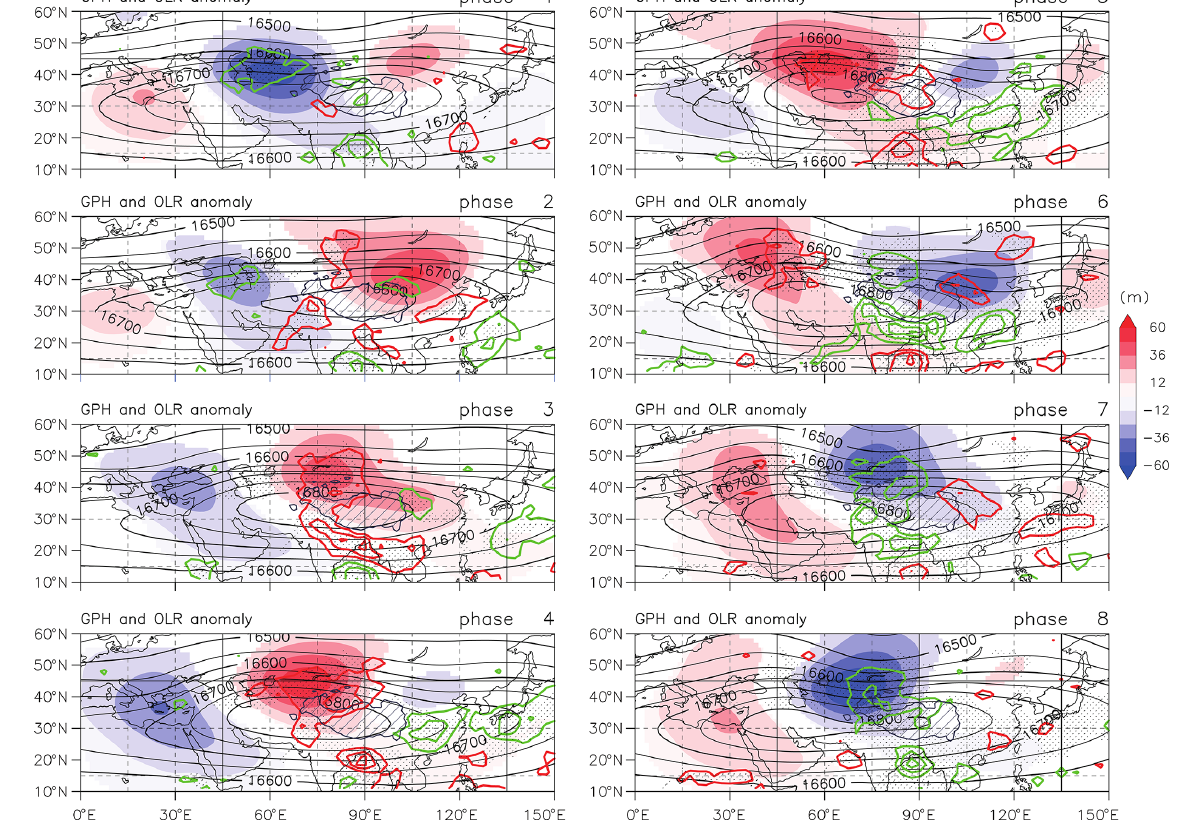
Figure 14. Composite maps of geopotential height (black contour) and its anomaly (shade) at the 100hPa level, and the OLR anomaly (green and red contour) for each phase. Anomalies are calculated as deviations from climatology. The contour interval for geopotential height is 50m. The contour interval for the OLR anomaly is 5Wm − 2 , with green and red contours respectively representing negative and positive anomalies. Shading of geopotential anomalies shows only areas with 95% significance by a standard t test. The areas of OLR anomaly with 95% significance are hatched by dots. Areas with an elevation above 3000m are